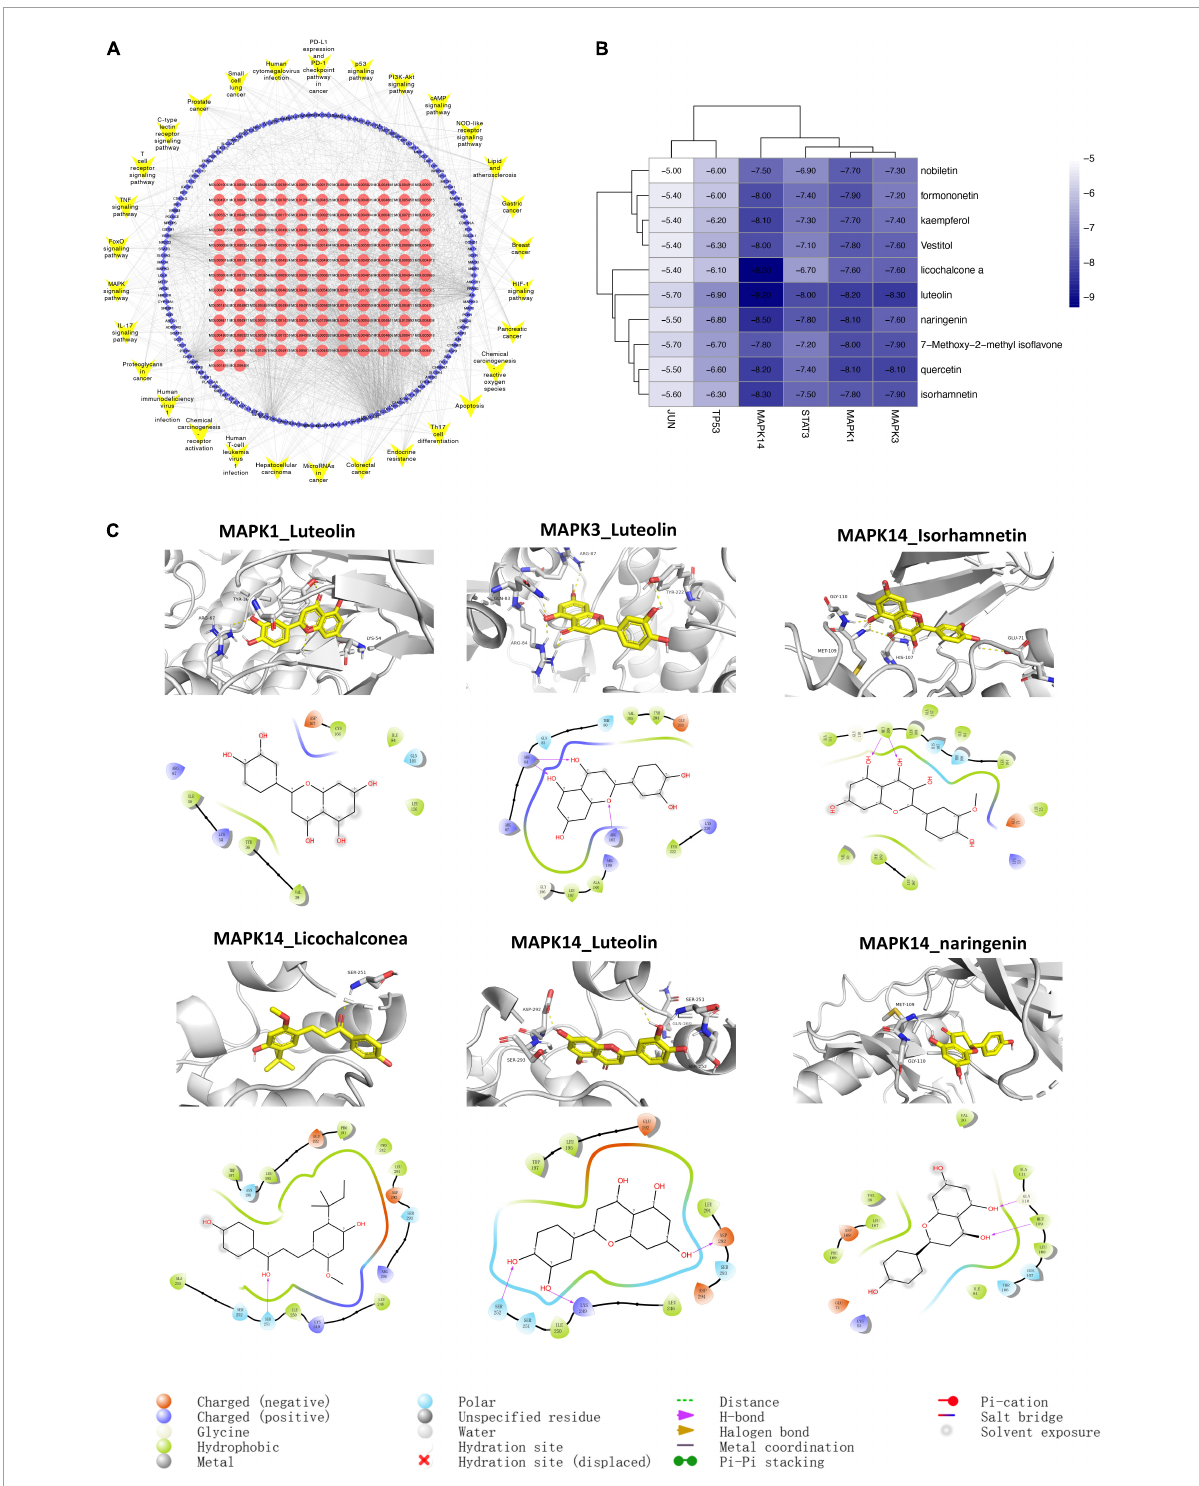
FIGURE7 Component-target-pathway network (A) and molecular docking (B,C) . (A) The blue diamonds represent genes. The red circle nodes denote components of SLD, and the yellow V nodes represent CAM-related signaling pathways. (B) Molecular docking results of core targets and active compounds. The color indicates an affinity score. Dark blue represents the lowest affinity score and the highest affinity between receptor and ligand. White represents the highest affinity score and the lowest affinity between receptor and ligand. (C) Optimal complex structure of components and